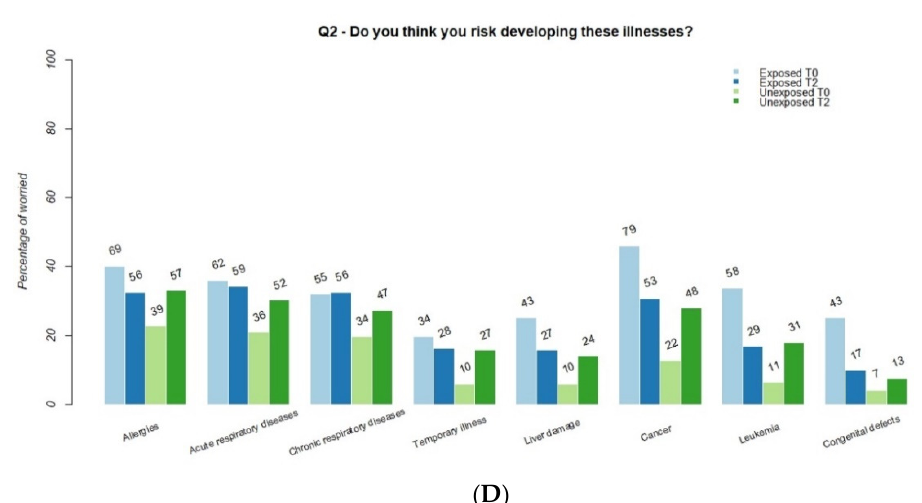
Figure 2 . (Panels A – D ). Change in percentage of concern for the two groups (extremely, very; or Figure 2. (Panels A – D ) Change in percentage of concern for the two groups (extremely, very; or certain, very probable) from T0 (before WTE start-up) to T2 (after three years of functioning). Table 2. Difference-in-differences (DID) results controlled for educational level. Absolute values and percentage of worried people are reported for each item of the